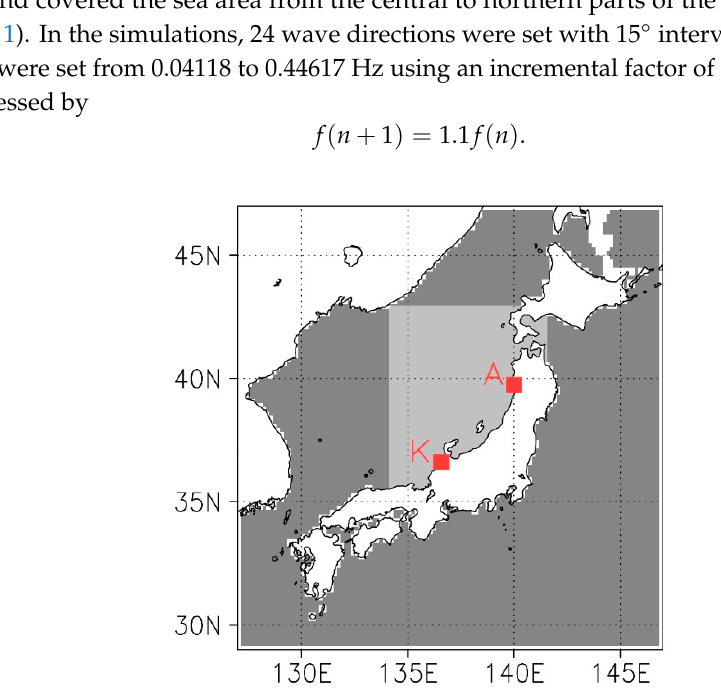
Figure 1. Target domains of the wave simulation. Darker region is the parent domain and brighter region is the child domain. The Nationwide Ocean Wave information network for Ports and HArbourS (NOWPHAS) observation sites at Akita and Kanazawa are indicated by red squares with initials A and K, respectively.